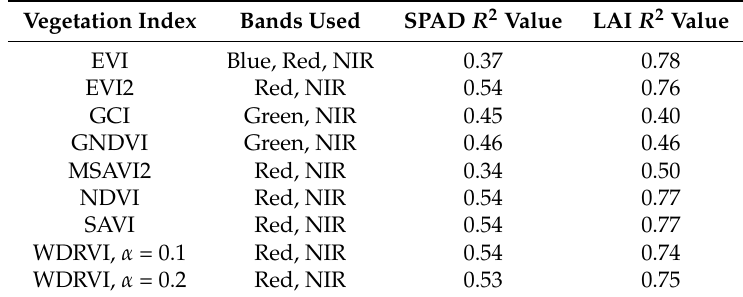
Table 2. Candidate vegetation indices, the relevant image bands, the R 2 value of their linear correlation with Soil Plant Analysis Development (SPAD) measurements, and the R 2 value of their linear correlation with leaf area index (LAI)